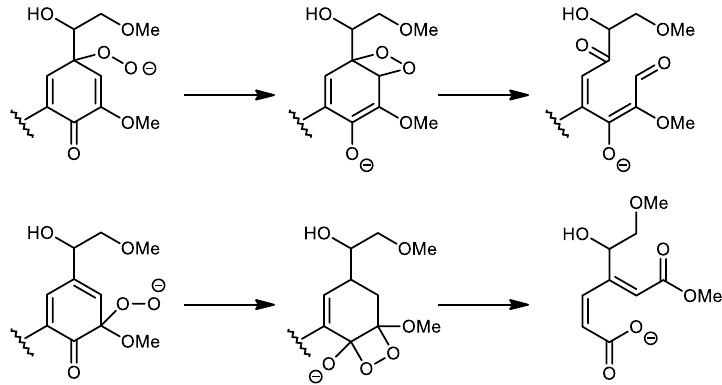
Figure 2. Oxidative ring-opening of the aromatic structures.